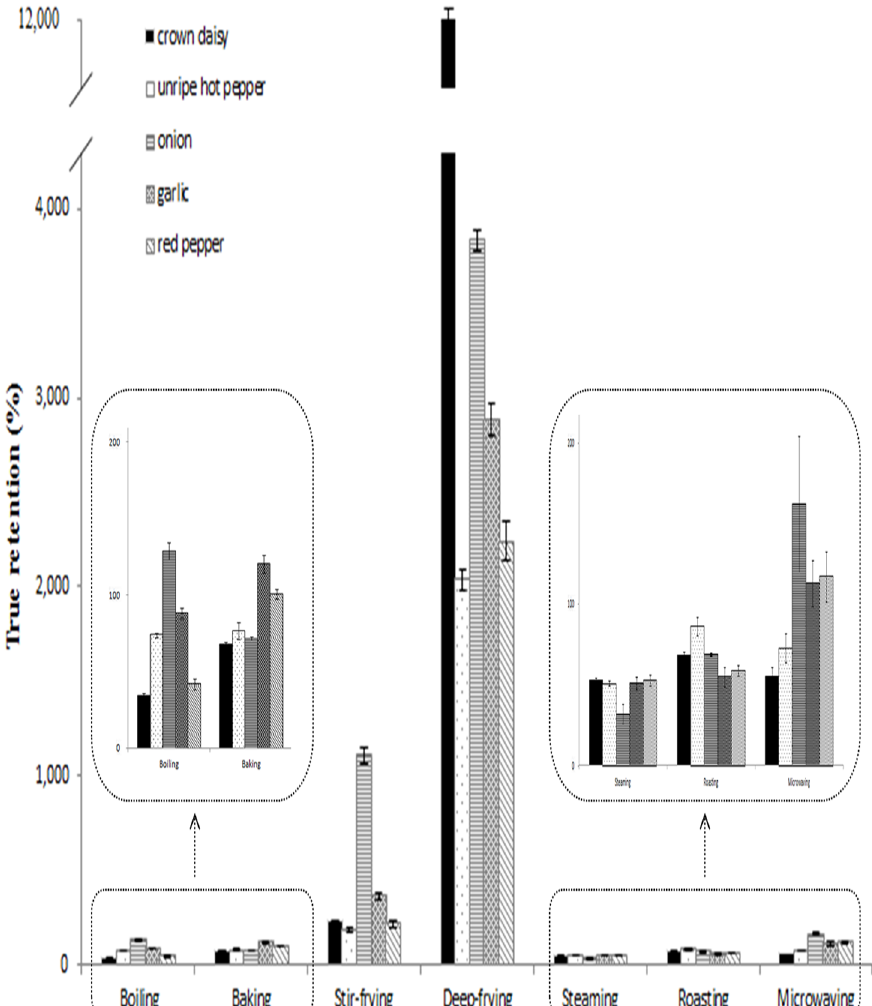
Fig 3. True retention of fat for 5 spices cooked in different